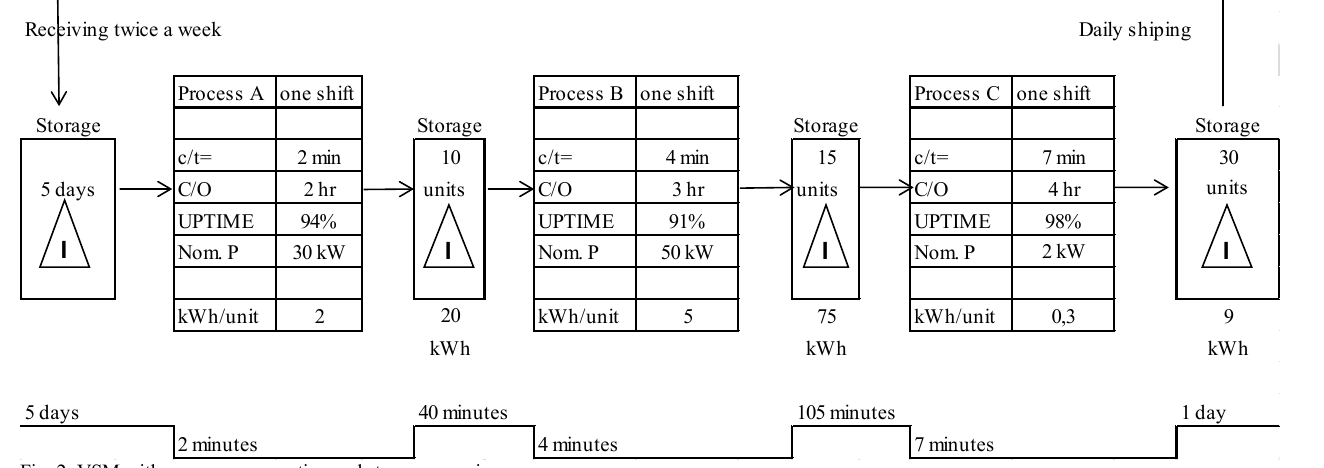
Fig. 2. VSM with energy consumption and storage